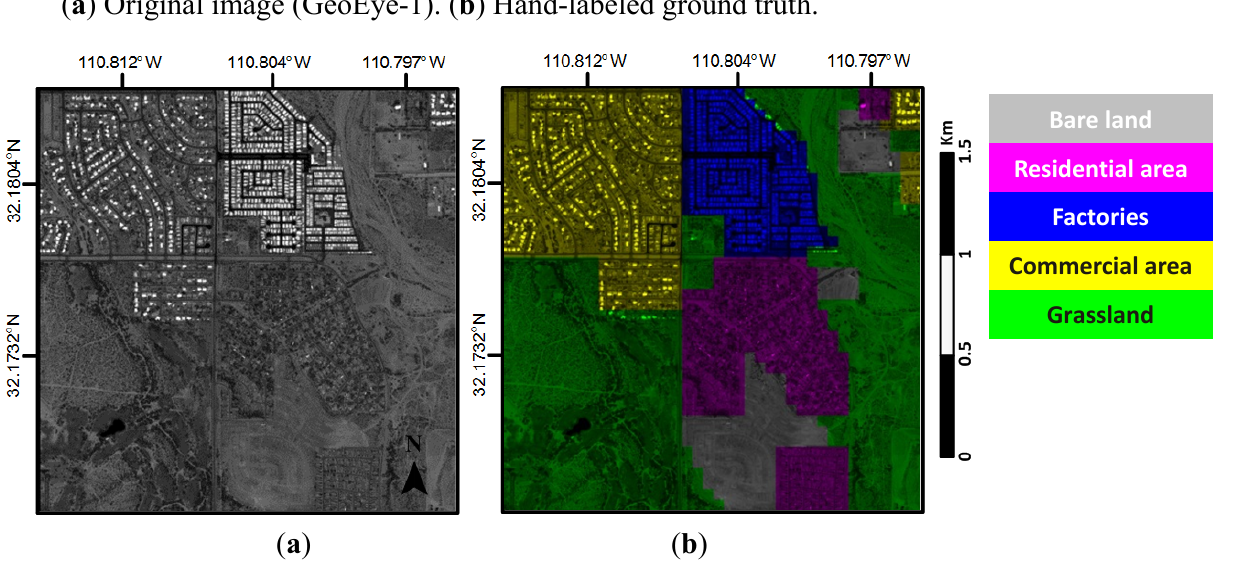
Figure 5. Original image I, to be annotated, and corresponding hand-labeled ground